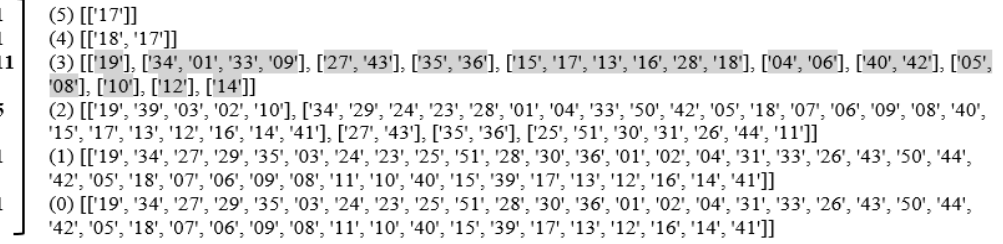
Figure 8. The q–connectivity list and corresponding state Q-vector. The left-hand column is the state Q-vector, the number in the parentheses indicates the q-level, the square brackets indicate the connected components. The highest q-value (30) shows for this time interval 31 TUs were in state medium control temperature, although only 24 TUs had medium set point (q = 23), while 16 TUs had a high set point (q = 15). A total of 12 TUs had low temperature error, while 5 TUs had high temperature error, 2 TUs were at maximum cooling power and maximum heating power. Using the incidence matrix as shown in Figure 5, it is possible to drill down to see which TUs are exhibiting anomalous behavior in an automated manner.